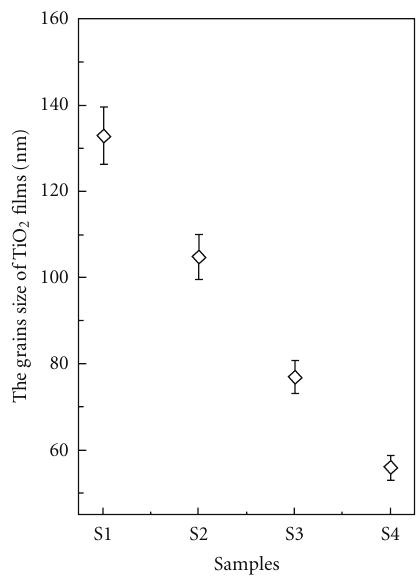
Figure 2: The distribution of grains dimensions.